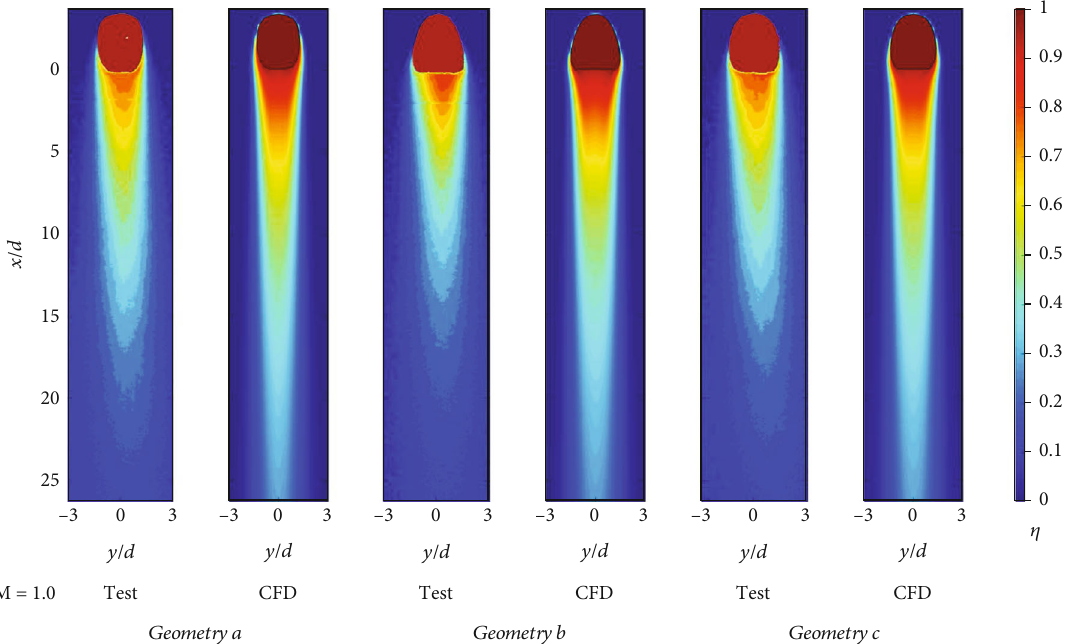
Figure 11: Test and CFD comparison of e ff ectiveness contours for the blowing ratio of